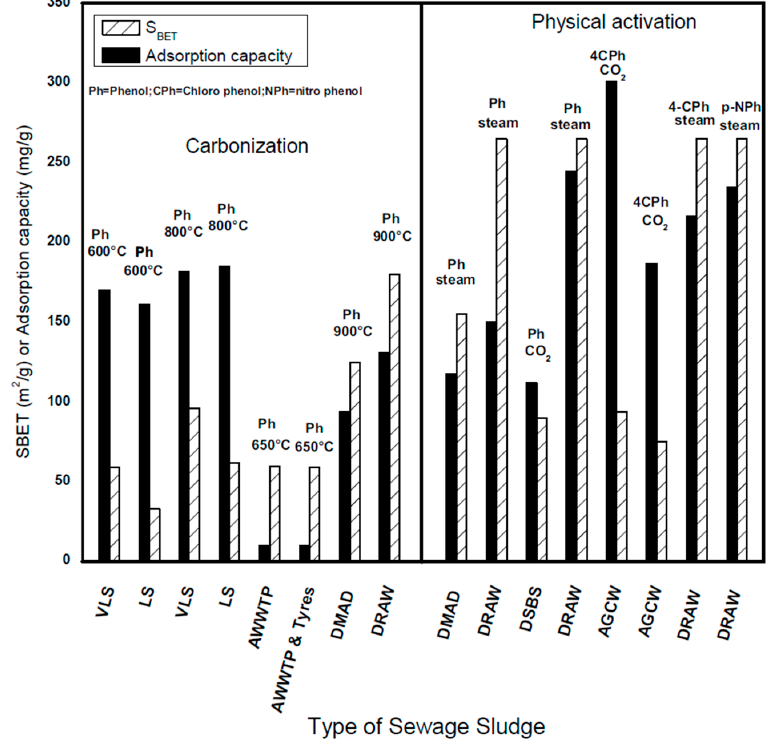
Figure 3. Achieved SBET in relation to uptake for phenolic compounds for physically activted SBAC.